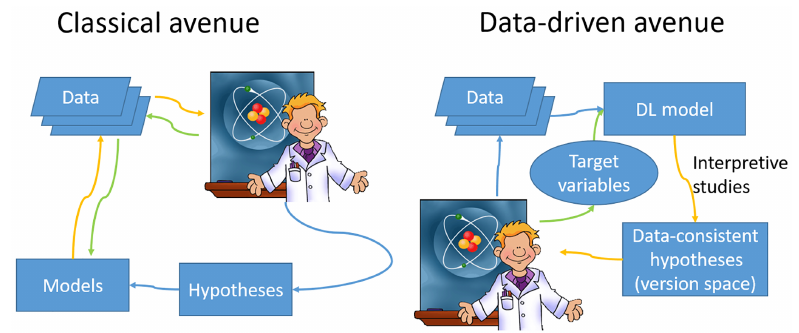
Figure 2. Comparing two alternative avenues toward gaining knowledge from data. In the classical avenue, scientists compile and interpret data, form hypotheses, and (optionally) build models to describe data and hypotheses (the green pathway). Then the model results with data to affirm or reject the hypotheses and the feedbacks (the yellow pathway) allow the scientist to revise the model and iterate. In the data-driven avenue, scientists collect data and define the target variables of DL models (the green path). Then interpretive methods are invoked to extract data-consistent and human-understandable hypotheses (the yellow path). There must be a hypotheses validation step where data withheld from training is used to evaluate or reject the